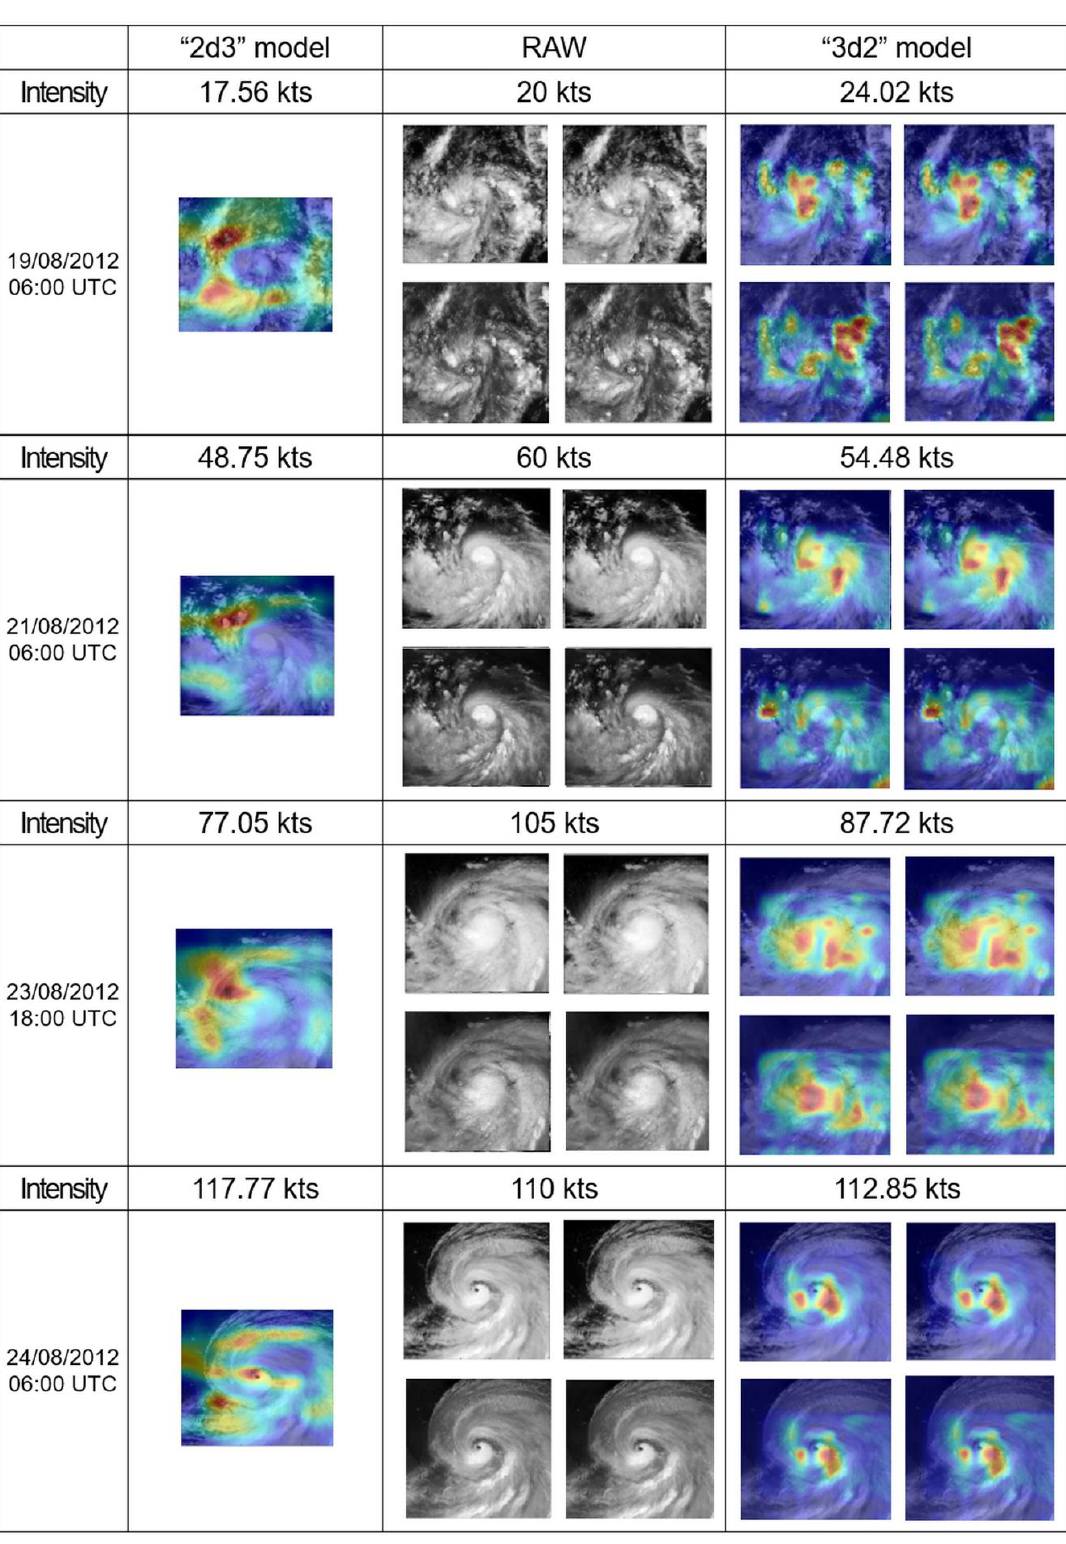
Figure 10. Validation results and heat maps of the 2D-CNN based “2d3” model and 3D-CNN based “3d2” model in case of BOLAVEN in 2012. The more reddish the shade on the heat map, the greater its importance in the model estimation process. Upper left: IR2 (channel 1), Upper right: IR1 (channel 2), Lower left: wv (channel 3), Lower right: swir (channel 4) in Raw and “3d2” column.